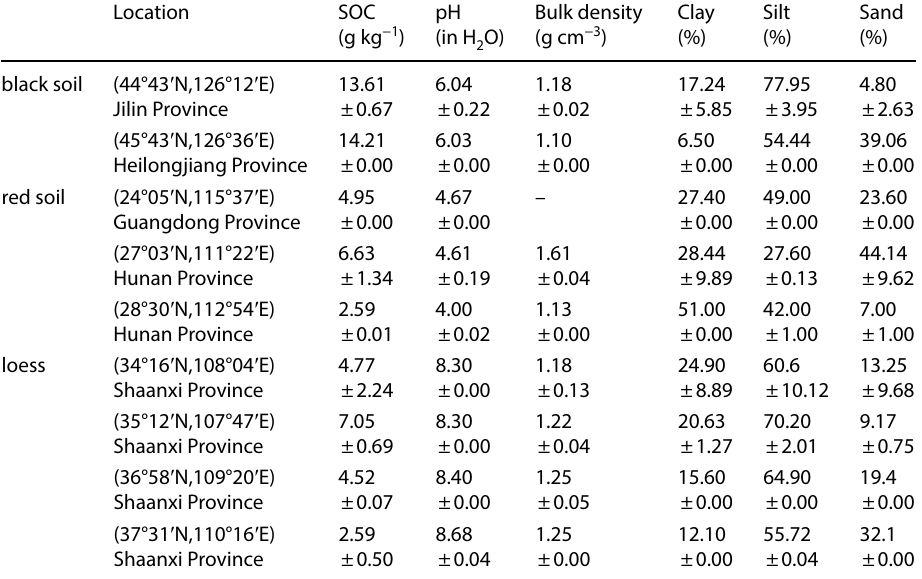
Values are means of acquired data (± standard error) Soil types are based on the genetic classification for